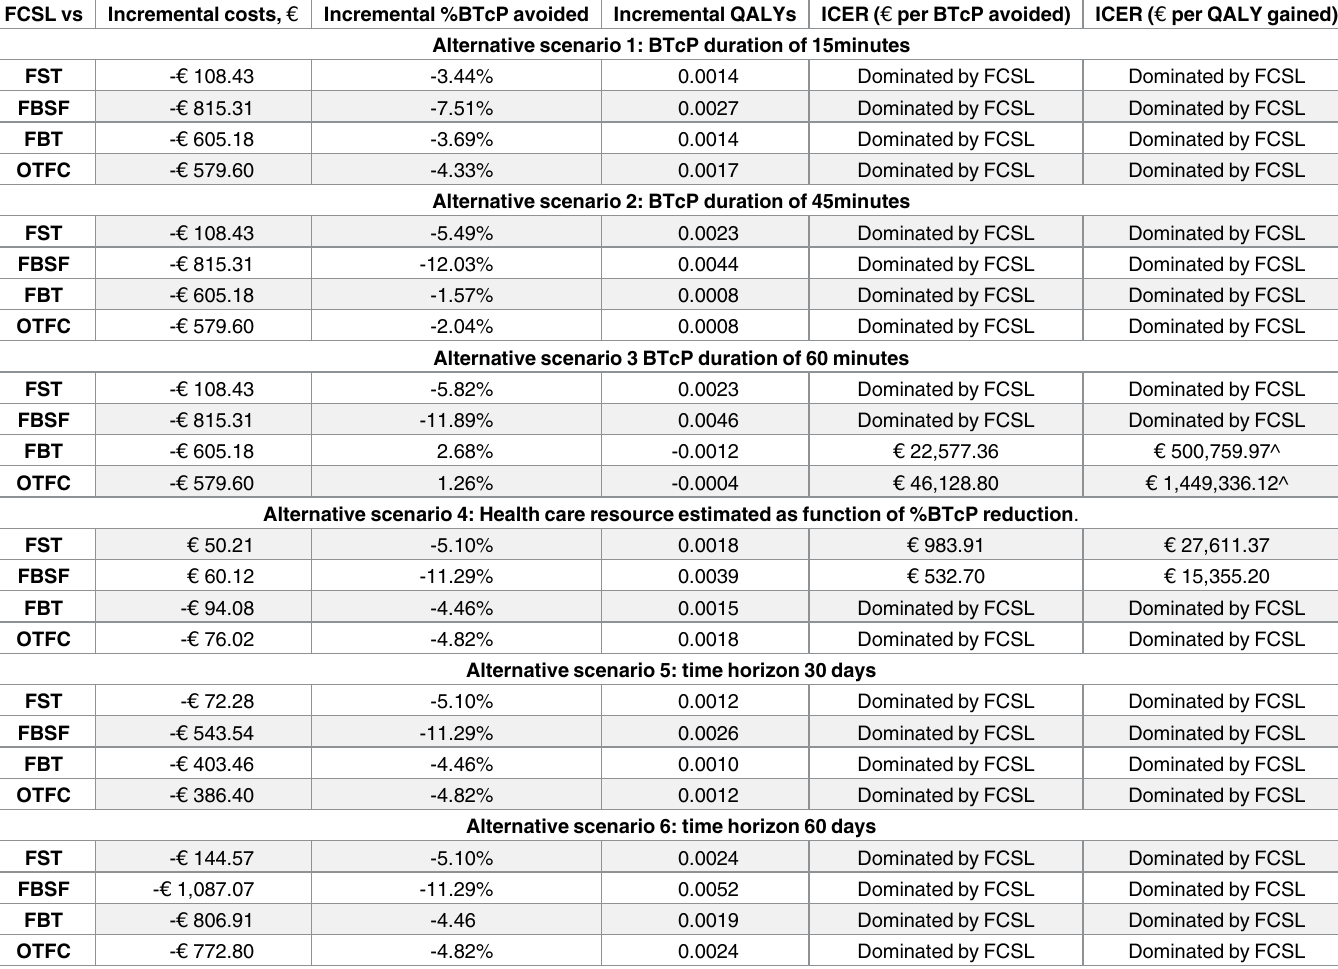
Table 5. Deterministic sensitivity analysis: Results of the 7 alternative scenarios